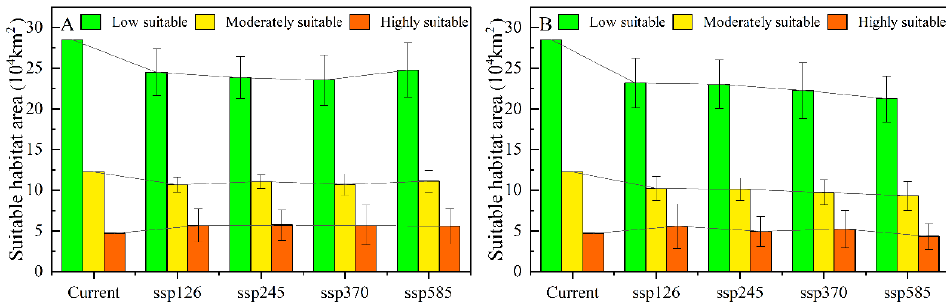
Figure 5. Area of typical locust suitable habitat assuming different scenarios. ( A ) 2030s, ( B ) 2050s. The error bars represent the standard deviation between the results of the 20 GCM models.